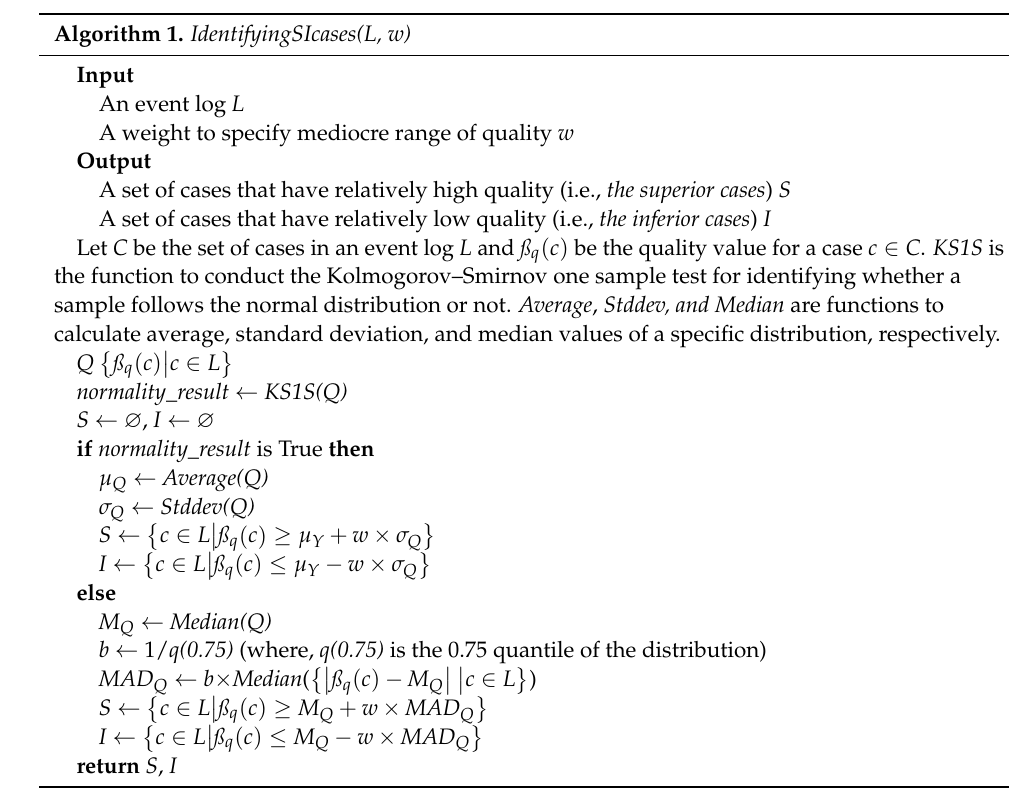
Algorithm 1. IdentifyingSIcases(L,